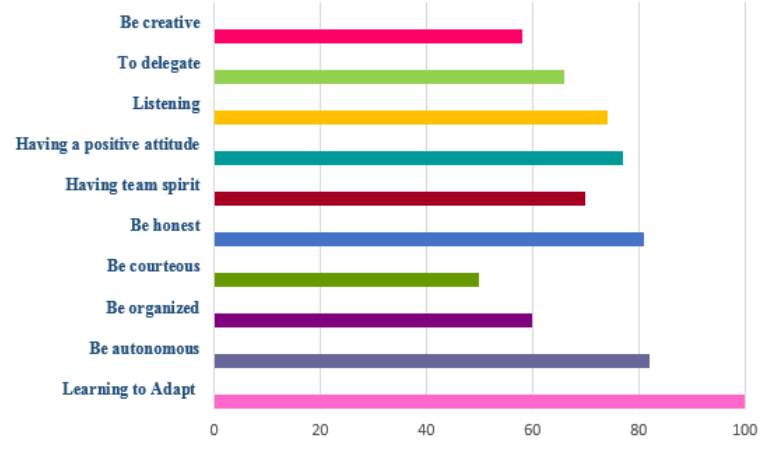
Fig. 1. The soft skills useful in a professional